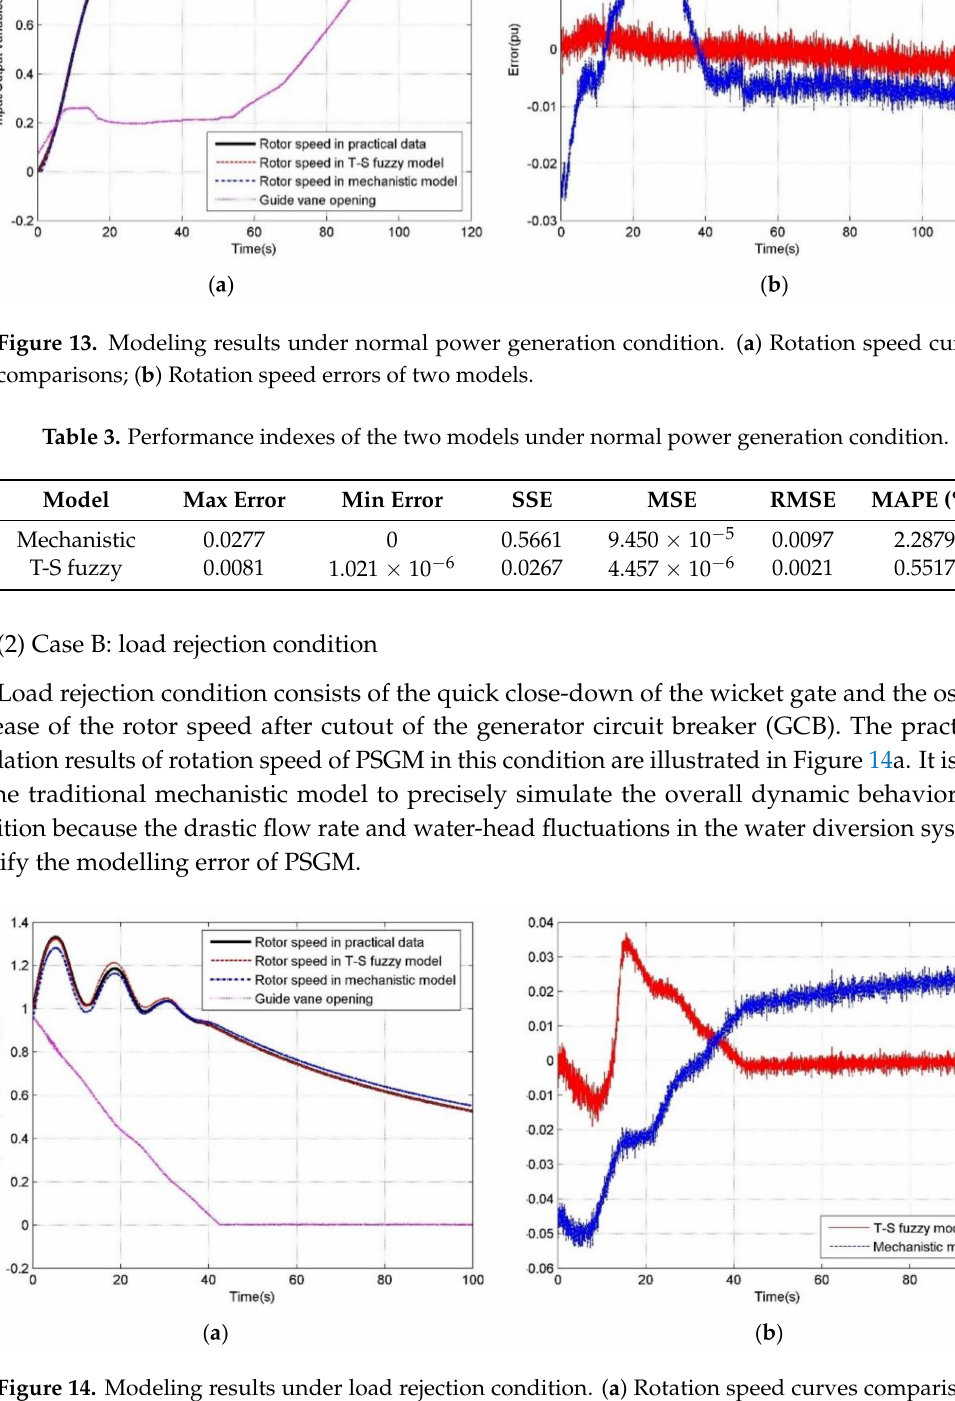
Figure 14. Modeling results under load rejection condition. ( a ) Rotation speed curves comparisons; ( b ) Rotation speed errors of two